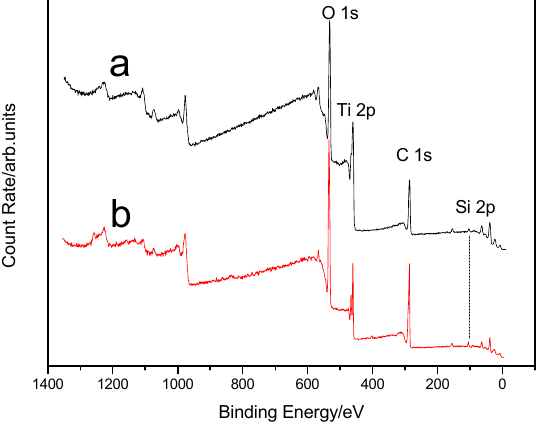
Polymers 2022 , 14 , 2489